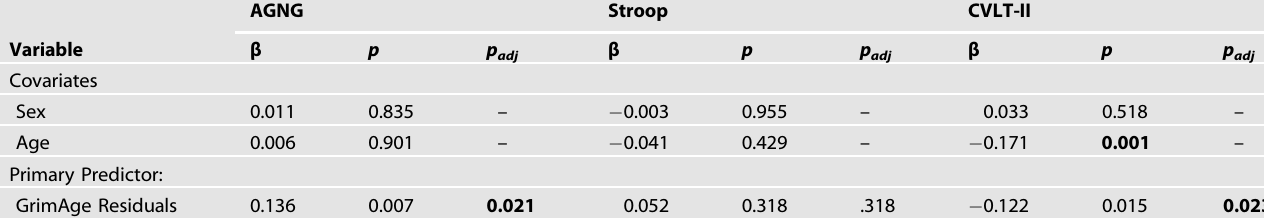
Table 3. GrimAge residuals as a predictor of neuropsychological